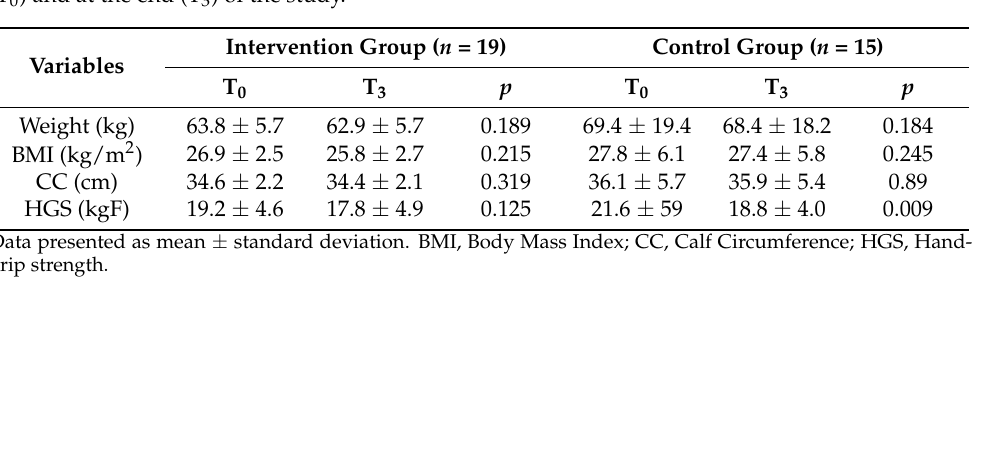
Table 2. Nutritional, anthropometric and handgrip strength measurements of patients at the baseline (T 0 ) and at the end (T 3 ) of the